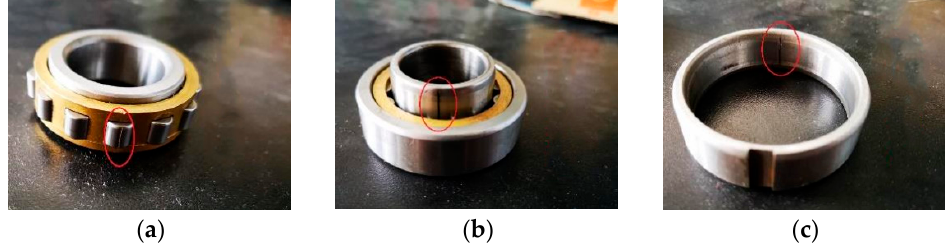
Figure 4. The different defects of rolling bearings: ( a ) rolling balls, ( b ) inner race, and ( c ) outer race.